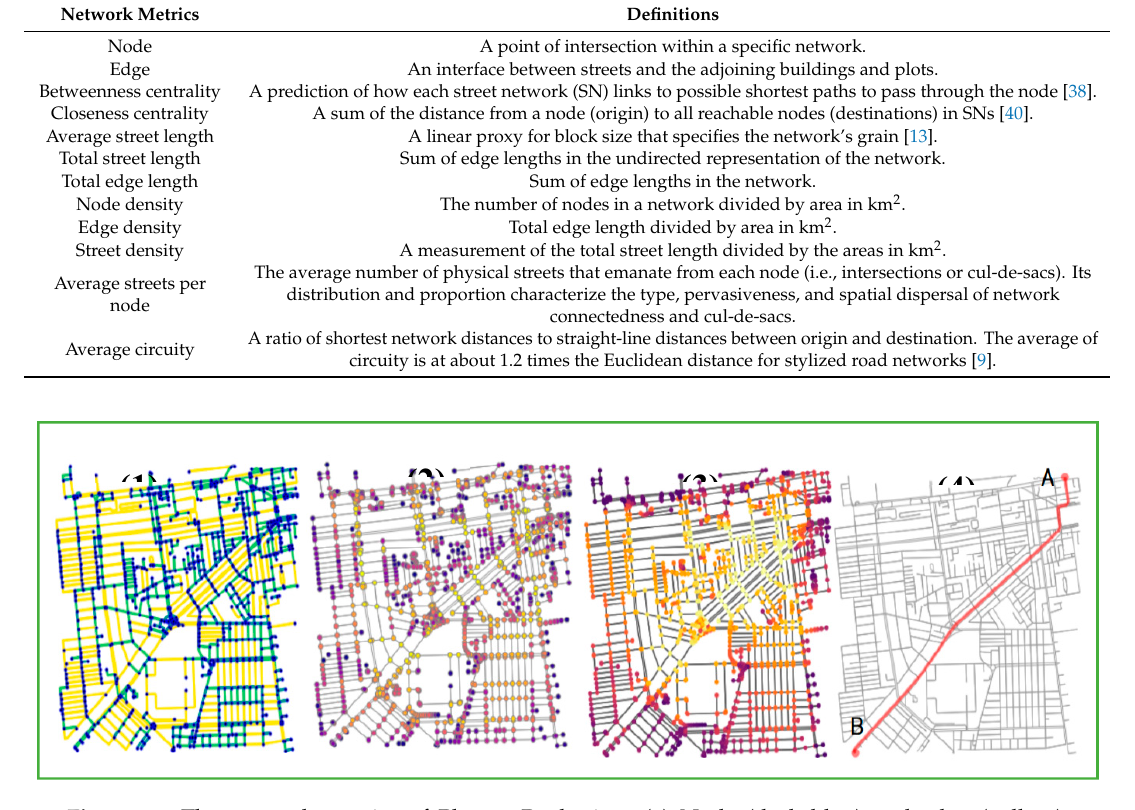
Figure 2. The network metrics of Phnom Penh city. ( 1 ) Node (dark blue) and edge (yellow), ( 2 ) betweenness centrality from lowest (dark) to highest (light), ( 3 ) closeness centrality from the lowest (dark) and highest (light), and ( 4 ) route distance from A to B.